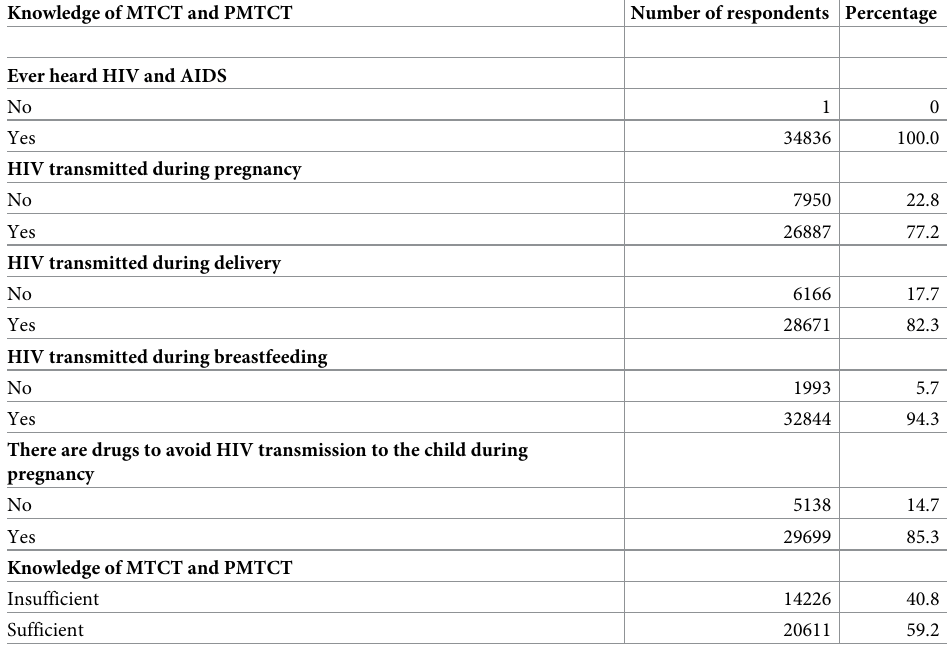
Knowledge of MTCT and